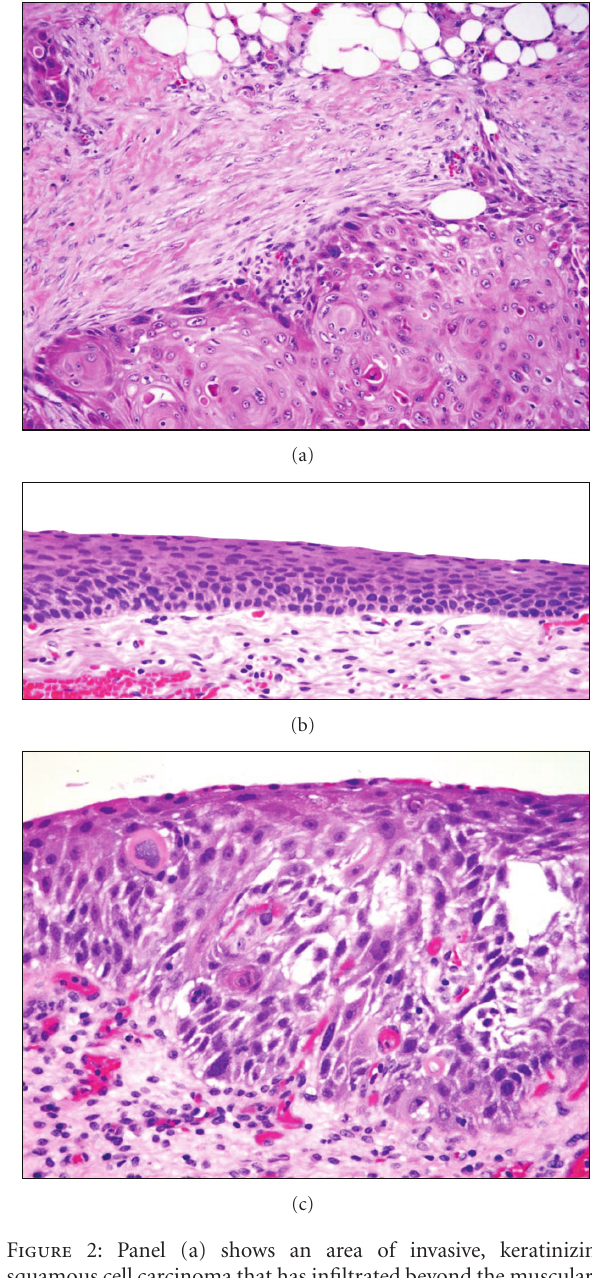
Figure 2: Panel (a) shows an area of invasive, keratinizing squamous cell carcinoma that has infiltrated beyond the muscularis propria (detrusor muscle) and into the perivesical adipose tissue. There is an associated desmoplastic reaction to the tumor. Panel (b) demonstrates the extensive squamous metaplasia seen in the background benign urothelium. Adjacent to the invasive tumor were foci of squamous cell carcinoma in situ (Panel (c)). Original magnification—200 × (panel (a)), 400 × (panels (b), and